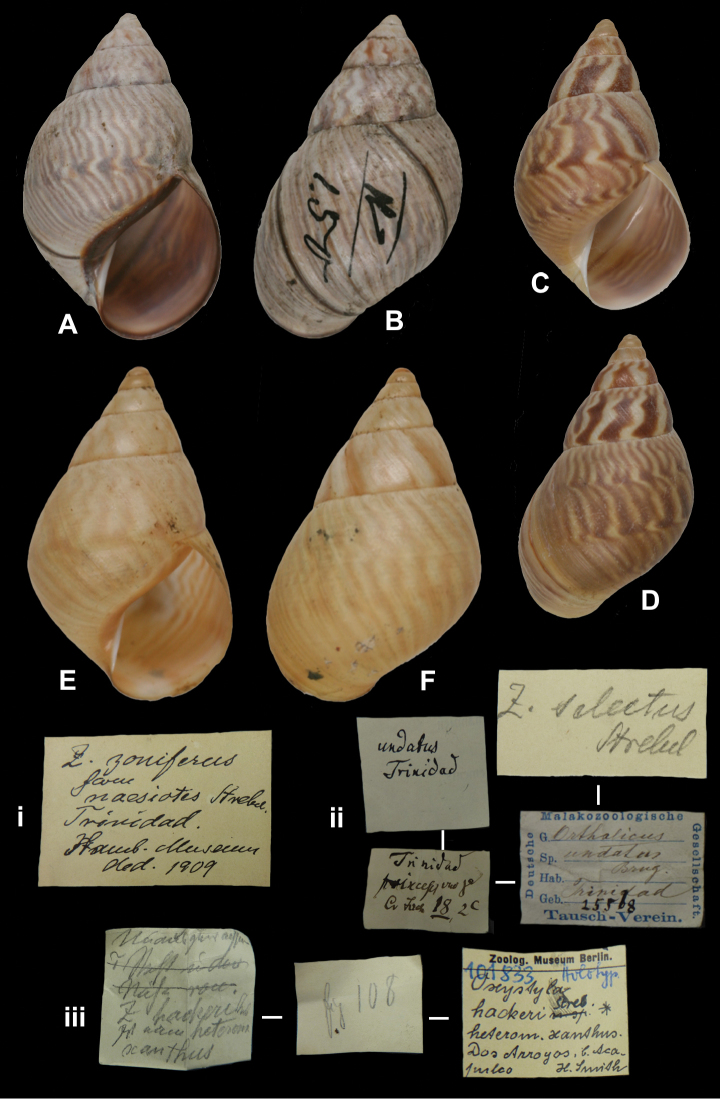
Orthalicus species A–D
Orthalicus undatus (Bruguière, 1789) A–B, i Syntype of Zebra zoniferus naesiotes Strebel, 1909 ZMB 117785 (H = 53.4) C–D, ii Syntype of Zebra selectus Strebel, 1909 (H = 50.3) E–F, iii
Orthalicus hackeri (Strebel, 1909), holotype of Zebra hackeri xanthus Strebel, 1909 ZMB 101833 (H = 57.4).